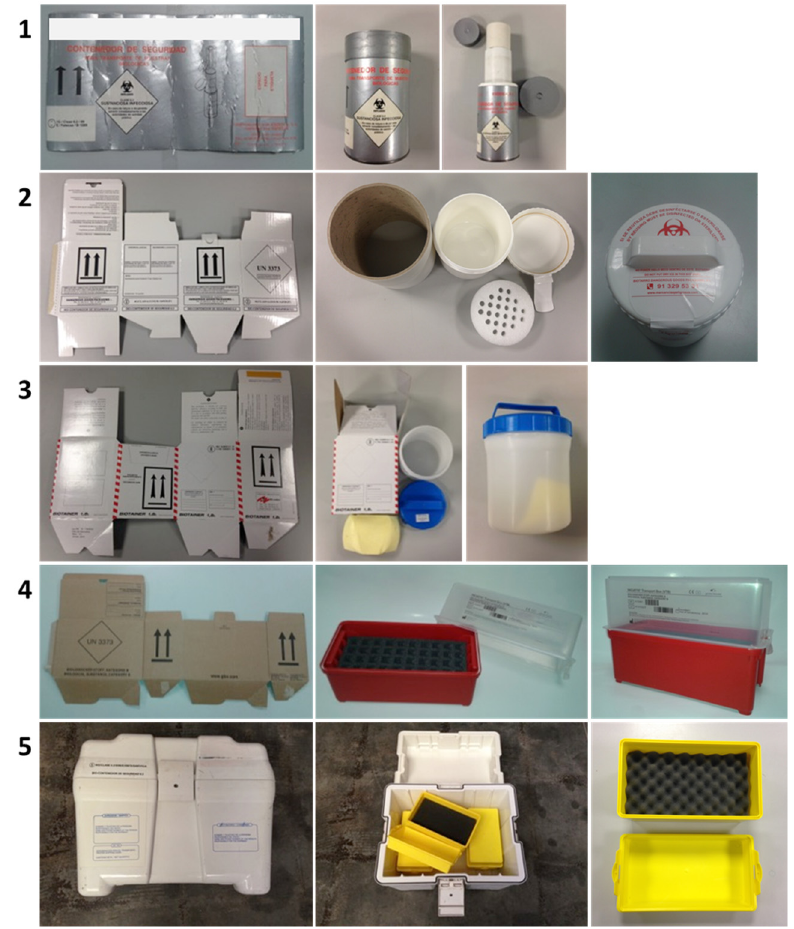
Figure 2. Commercial packaging for the transport of Category A infectious substances.